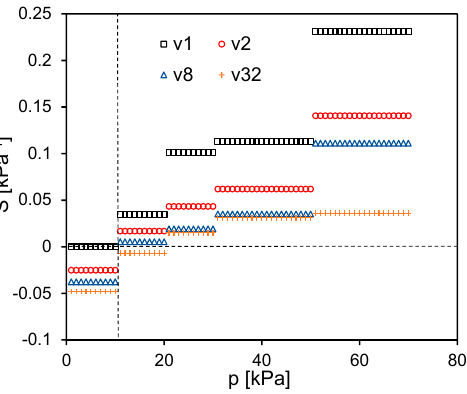
Figure 18. Sensitivity ranges of the fabricated sensor as function of the applied pressure and strain rate.